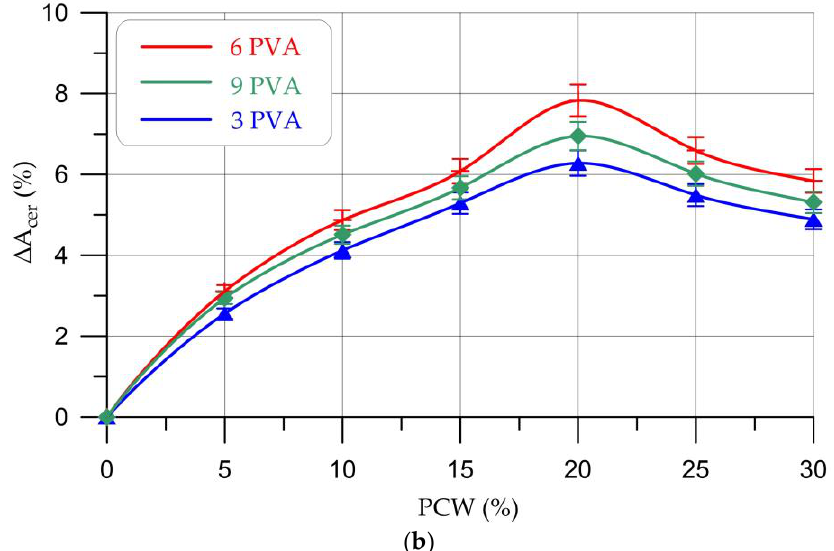
Figure 10. Change in adhesion of geopolymer composites ( a ) with a concrete base; ( b ) with ceramic base depending on PCW and PVA content.